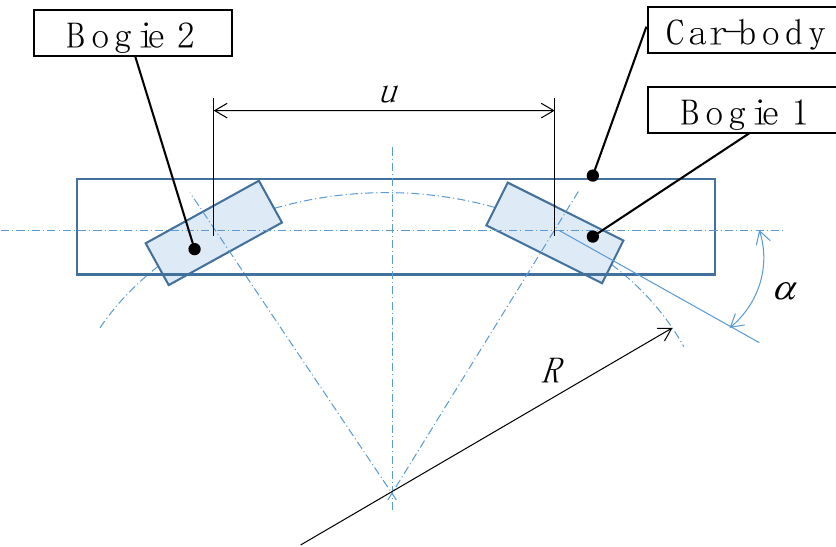
Figure 6. Planar view of a vehicle in the constant curvature track. Equation (1) is fully valid only when the whole vehicle is in a curved track of a constant curvature. Figure 7 shows simulation results of a vehicle negotiation of a R = 250 m track curve. It can be seen that in the transition track section, where the track curvature changes, the track curvature estimated by Equation (1) lags behind the actual track curvature on the leading bogie, whereas track curvature estimated on trailing bogie is ahead.